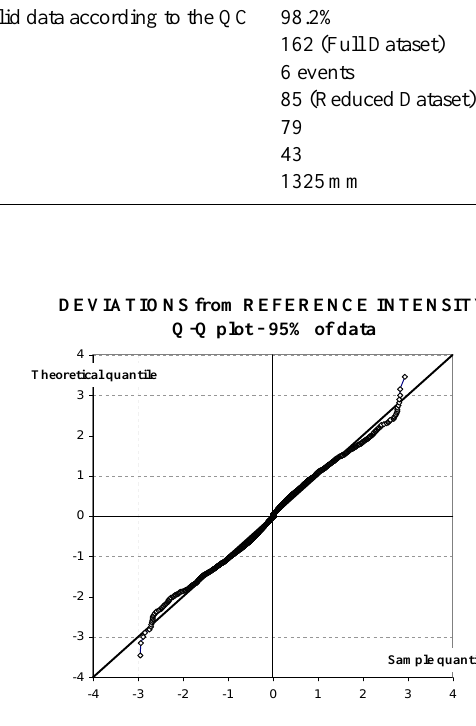
Fig. 3. Graphical normality test for the deviations of the pit gauges Fig. 3 : Graphical normality test for the deviations of the pit gauges from the reference intensity. A reduced sample size (central 95% of the whole set of data) is used to avoid the from the reference intensity. A reduced sample size (central 95% of influence of extremes. the whole set of data) is used to avoid the influence of